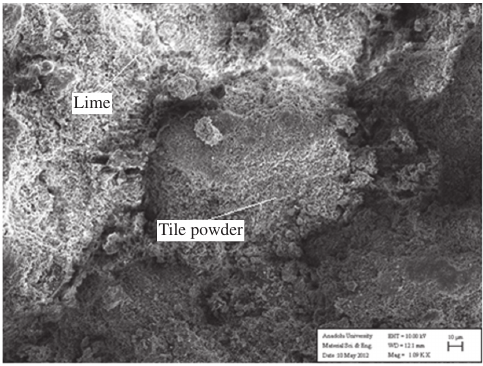
Figure 11 Secondary electron image of slaked lime.